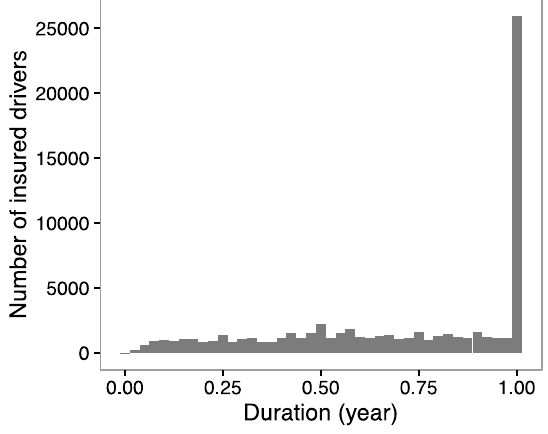
Figure 2. Distribution of the duration of PAYD contracts in 2011.